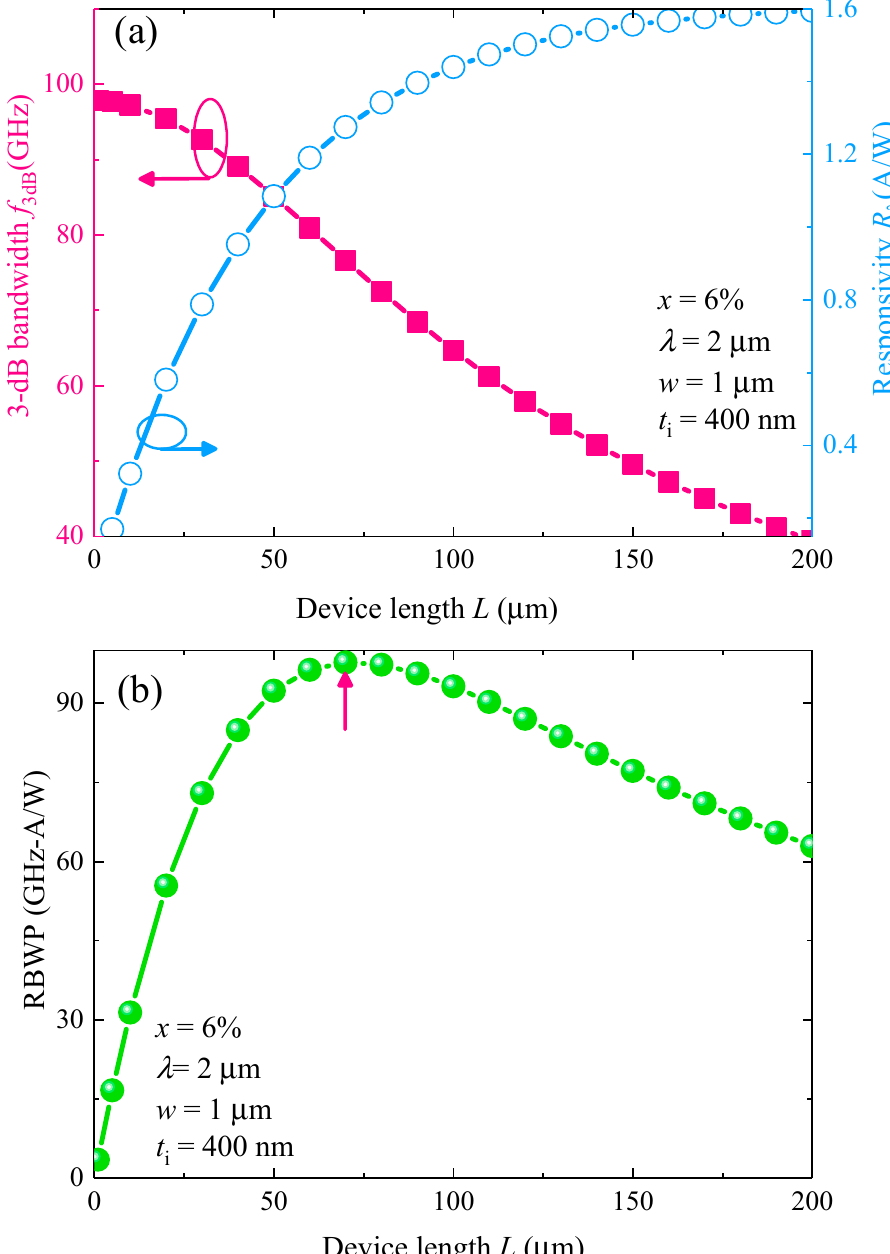
Figure 8. ( a ) Calculated 3-dB bandiwdth and responsivity as a function of device length at λ = 2 µ m. ( b ) Calculated responsivity-bandwidth product (RBWP) as a function of device length at λ = 2 µ m. The red arrow indicates the maximum RBWP.